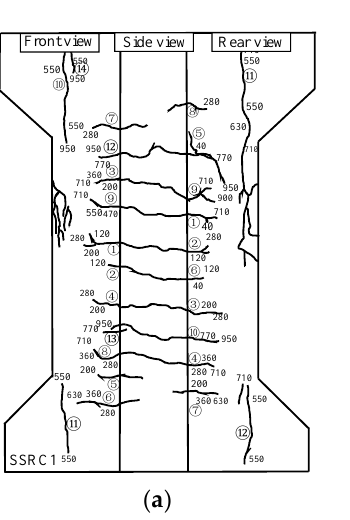
Figure 3. Typical failure modes for specimens: ( a ) small eccentric compression, ( b ) large eccentric compression, ( c ) side view, ( d ) compression side, and ( e ) tension side.